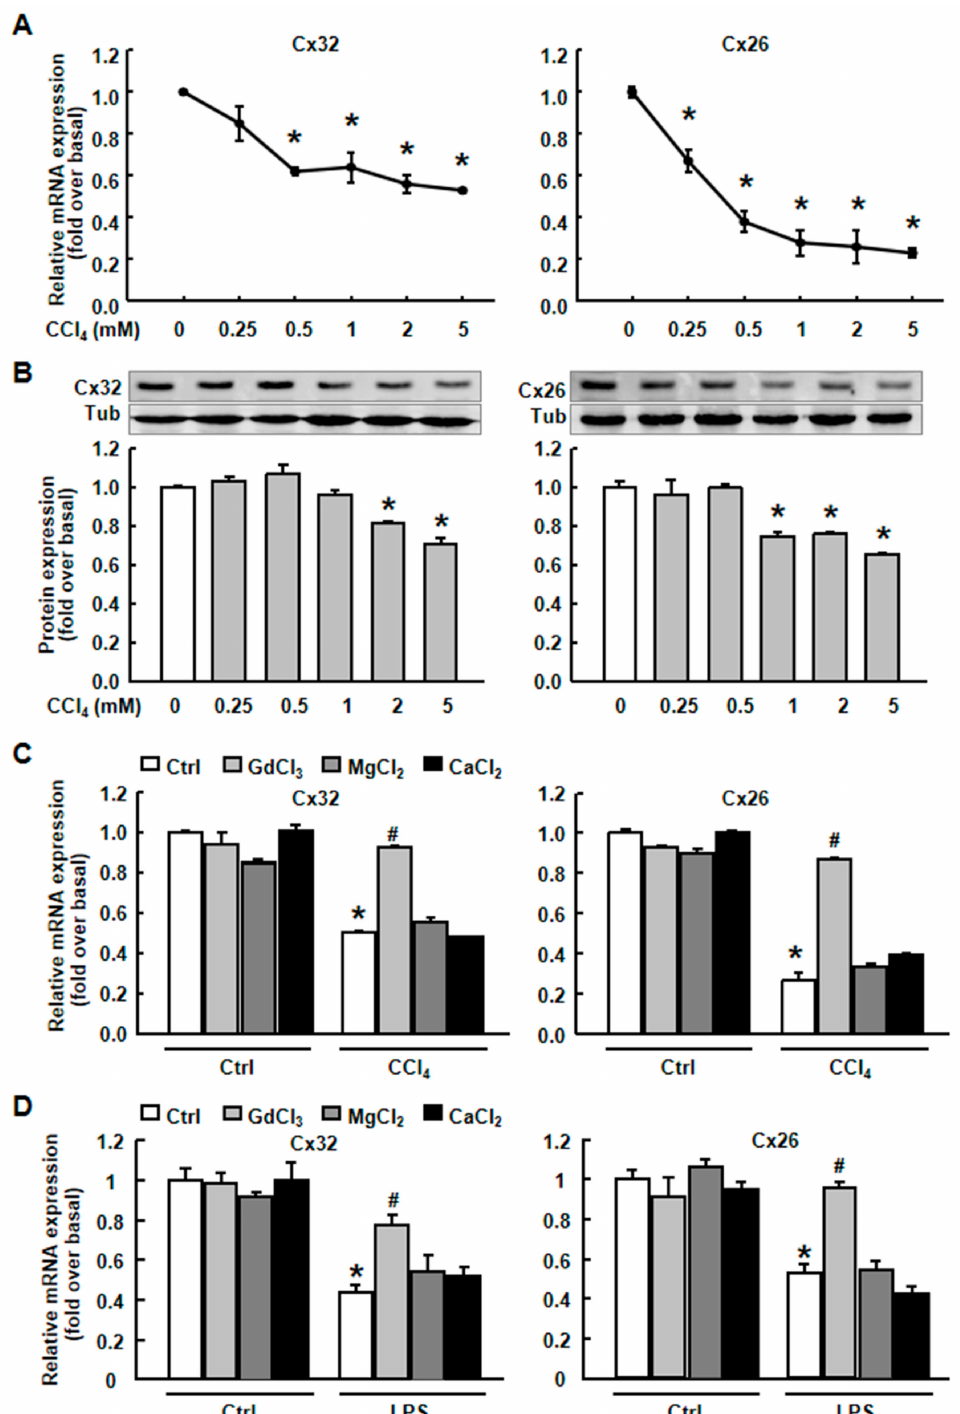
Figure 4. Cx32 and Cx26 expression in CCl 4 - or lipopolysaccharide (LPS)-injured primary hepatocytes with or without GdCl 3 pretreatment. The expression of Cx32 and Cx26 mRNA ( A ) and protein ( B ) in primary hepatocytes which were treated with CCl 4 of di ff erent concentrations. Cx32 and Cx26 mRNA expression in response to CCl 4 ( C ) or LPS ( D ) with the pre-treatment of 200 µ M GdCl 3 , 1 mM MgCl 2 or 1 mM CaCl 2 for 1 h, following 2 h of CCl 4 or LPS treatment. All results were confirmed in three independent experiments. Data are presented as the mean ± SEM, and were analyzed by ANOVA for analysis of variance. * p < 0.05 vs. Ctrl. # p < 0.05 vs. CCl 4 -treated hepatocytes without GdCl 3